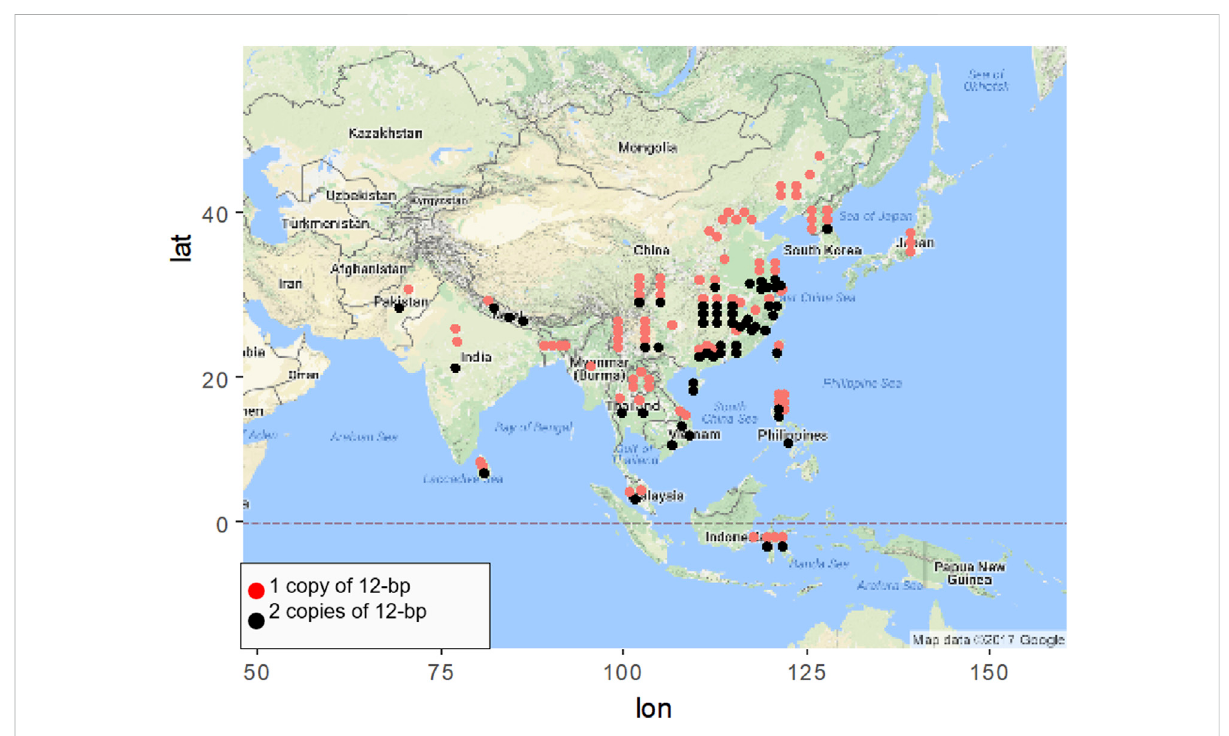
FIGURE 1 Geographical distribution of rice varieties containing the diverse NOG1